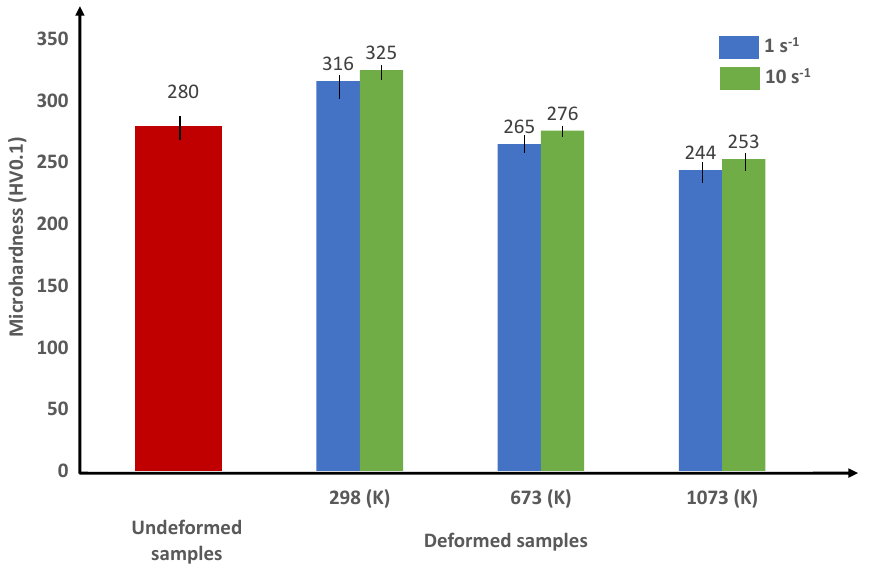
Figure 10. Vickers microhardness of the un-deformed and the deformed Ti42Nb alloy produced by LB-PBF with BD-45 ◦ at different temperatures and strain